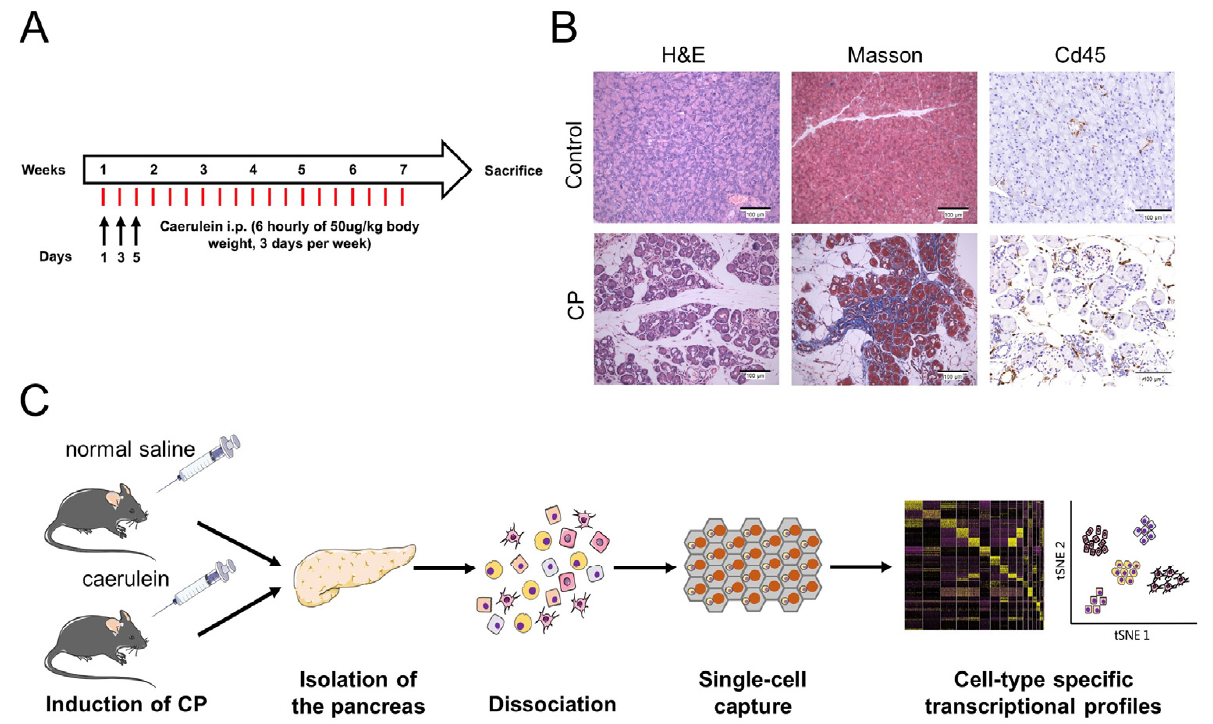
Figure 1. Induction of CP in mice. ( A ) Flow diagram of caerulein administration: six daily injections of caerulein given hourly on days one, three, and five of each week for six weeks. ( B ) H&E and Masson’s trichrome staining of pancreatic sections isolated from control and CP mice. The immuno- histochemical analysis showed an extensive infiltration of Cd45 leukocytes. Scale bar = 100 μ m. ( C ) Workflow for obtaining the single-cell transcriptome data from mouse pancreata.